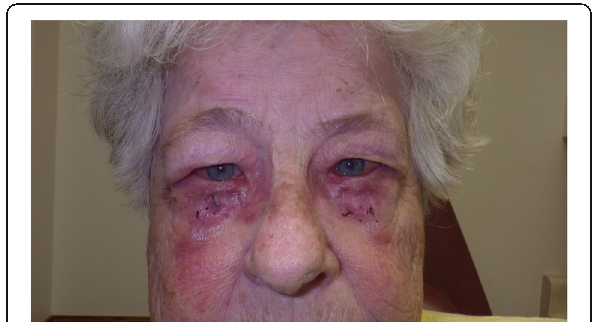
Fig. 2 Patient on postoperative day 7 following bilateral lower eyelid entropion repair. This patient illustrates an allergic reaction to the NPD ointment that she applied two to three times a day. This particular patient was also instructed to apply ointment onto the ocular surface for dryness causing a conjunctival reaction to the NPD that can be seen in the form of conjunctival edema and